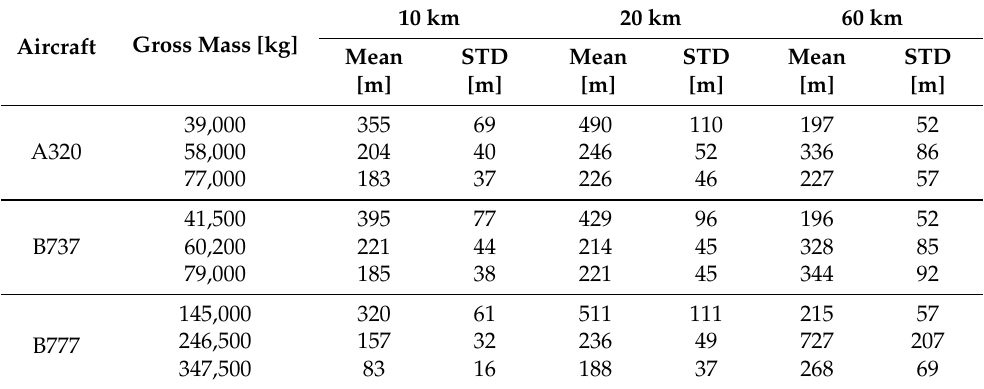
Table 2. Difference in gate height due wind at 10, 20, and 60 km along track distance from runway threshold for several aircraft configurations and all freely optimized flights.